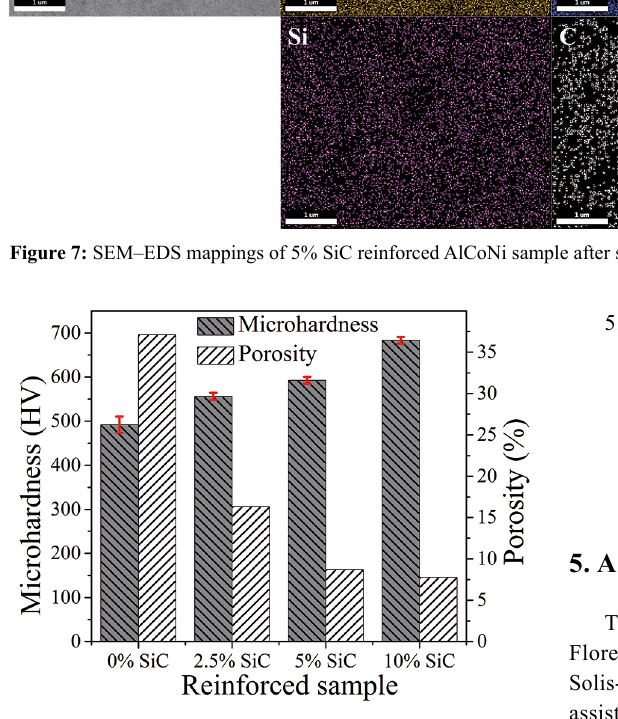
Figure 8: Microhardness and porosity of the sintered products